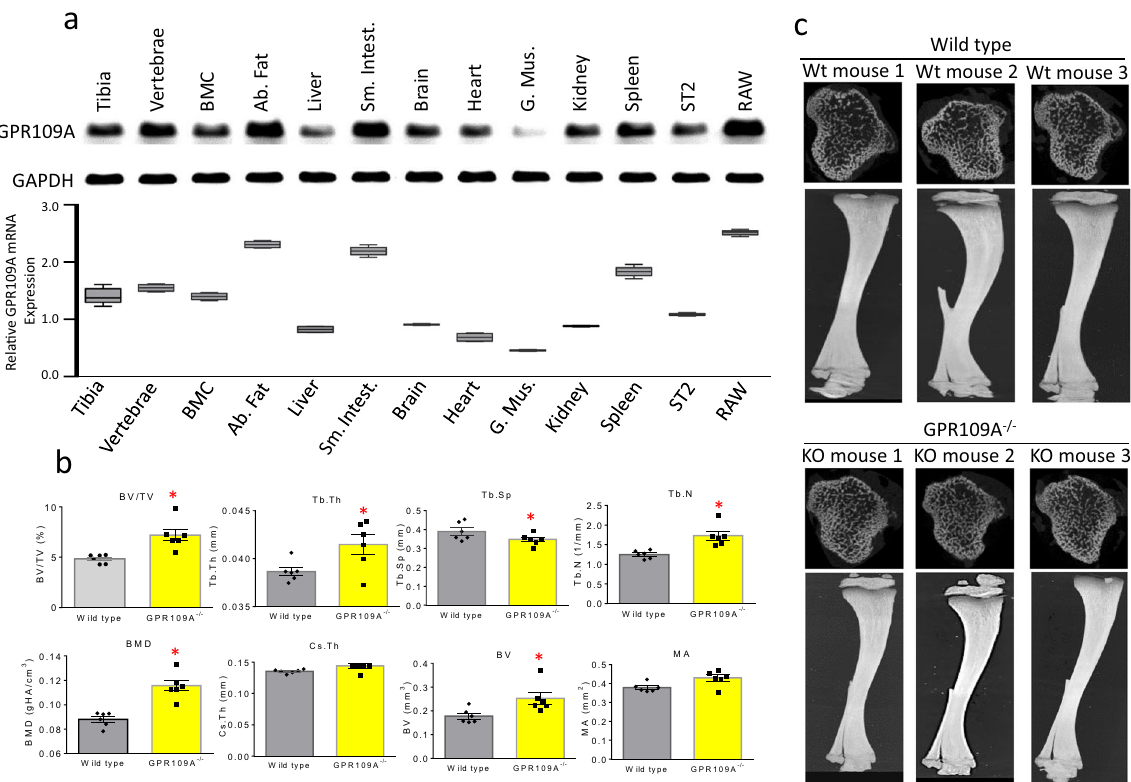
Wild type GPR109A -/-